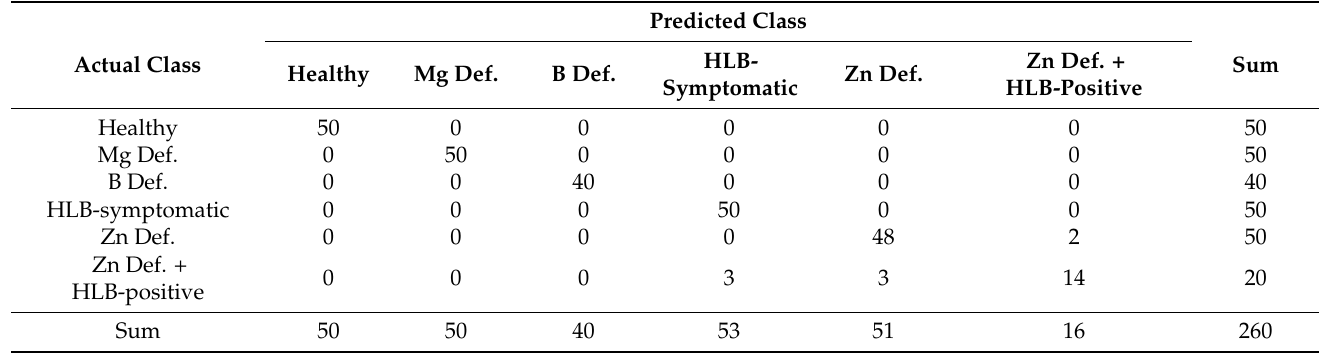
Table 2. Confusion matrix for all category